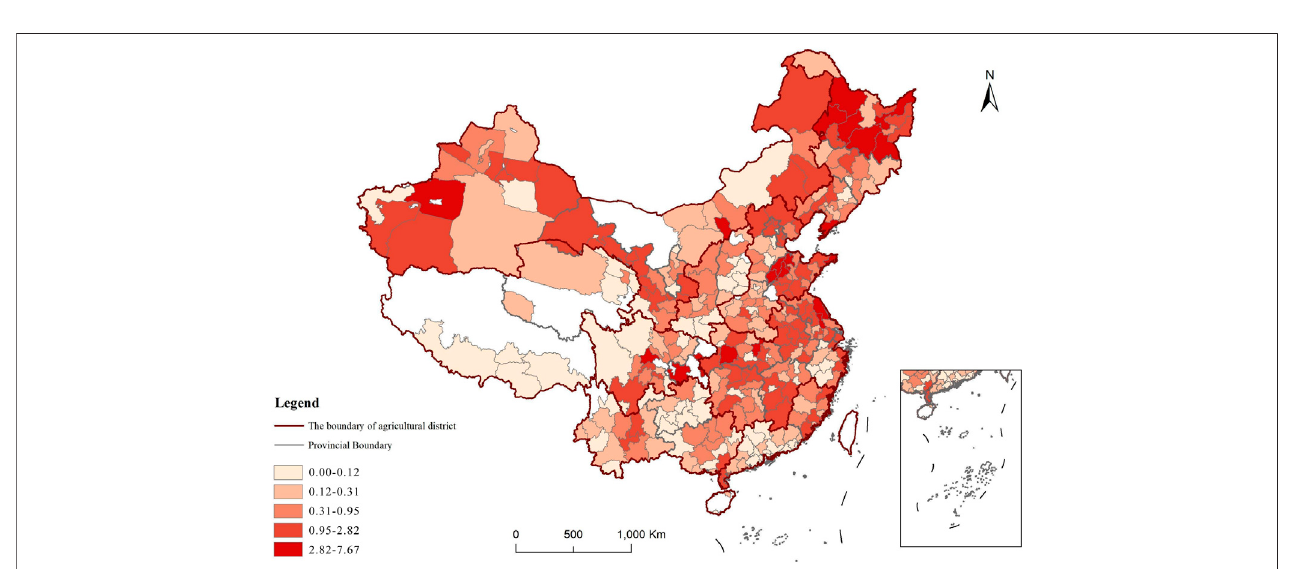
FIGURE 4 | Spatial features of the production concentration of the green food industry in